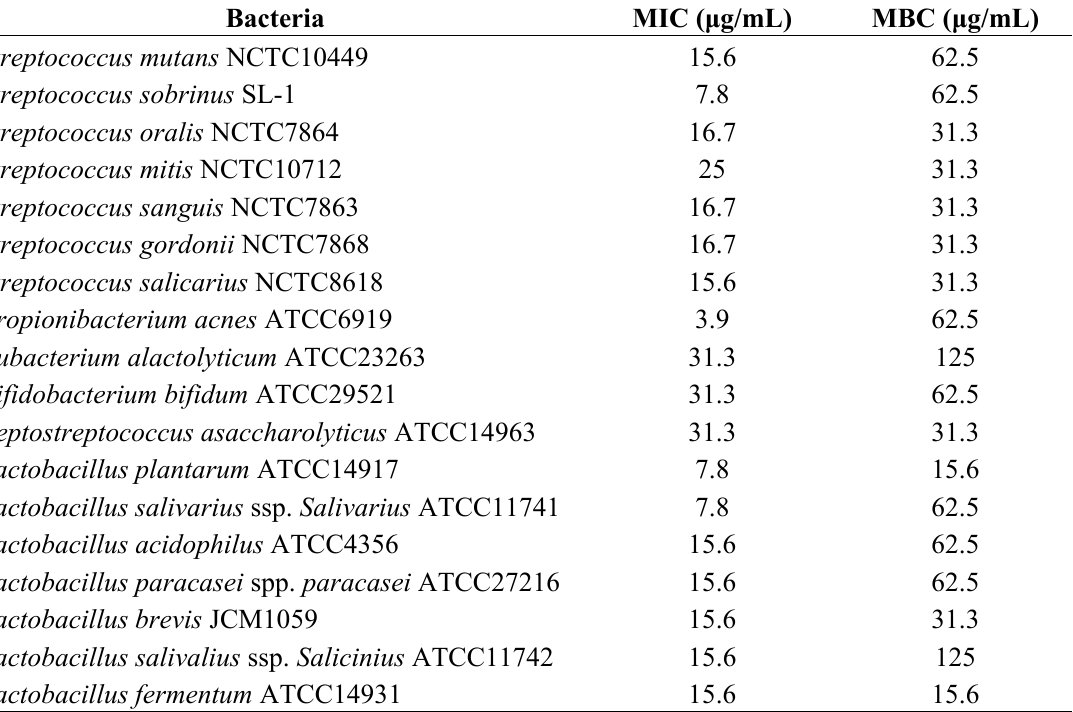
Table 2. MIC and MBC values of MDPB against different bacteria